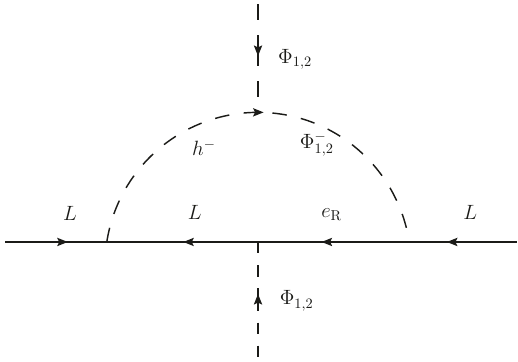
Figure 1. The Zee model diagram for neutrino